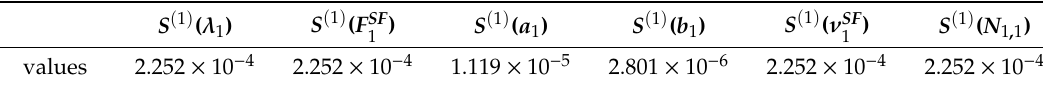
(cid:16) (cid:17) q j for isotope 239 Pu.